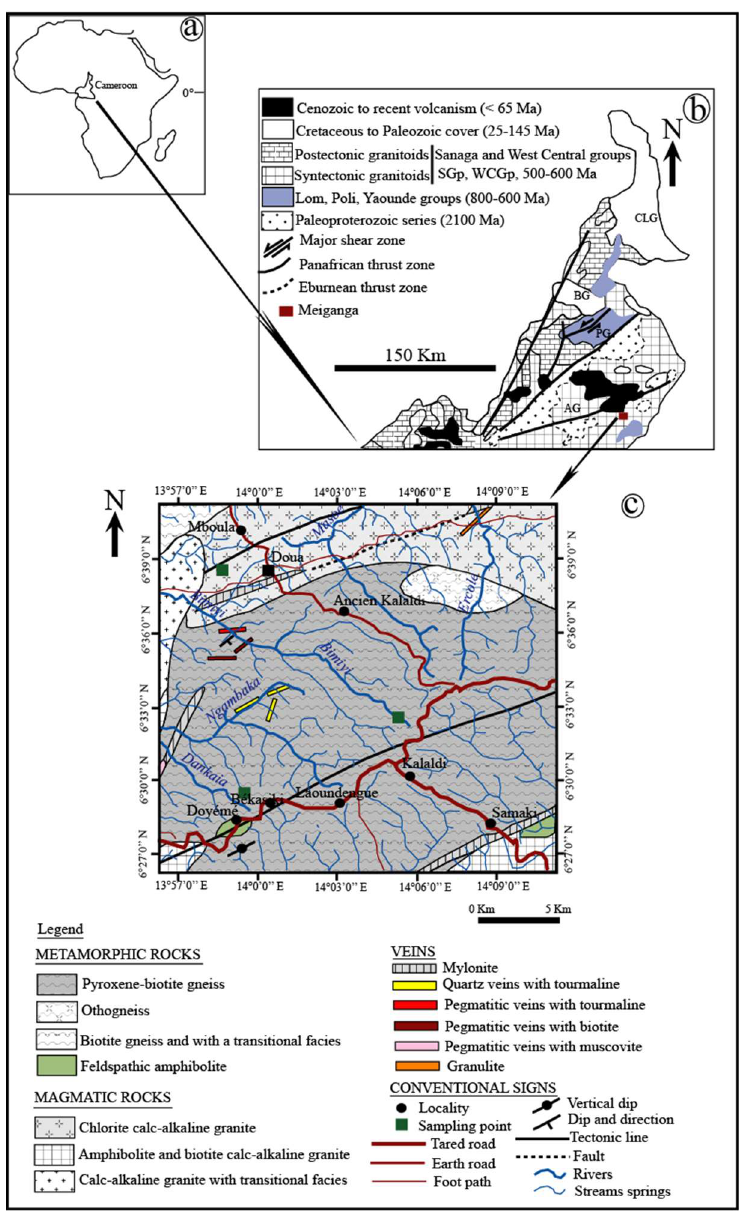
Figure 1. Sketch geologic map locating West of Meiganga within the local and regional settings.